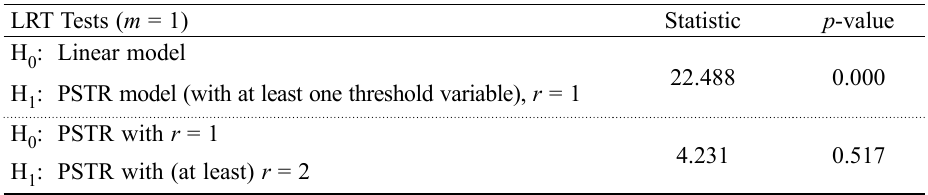
Table 2. Determination of the homogeneity tests for large-sized banks